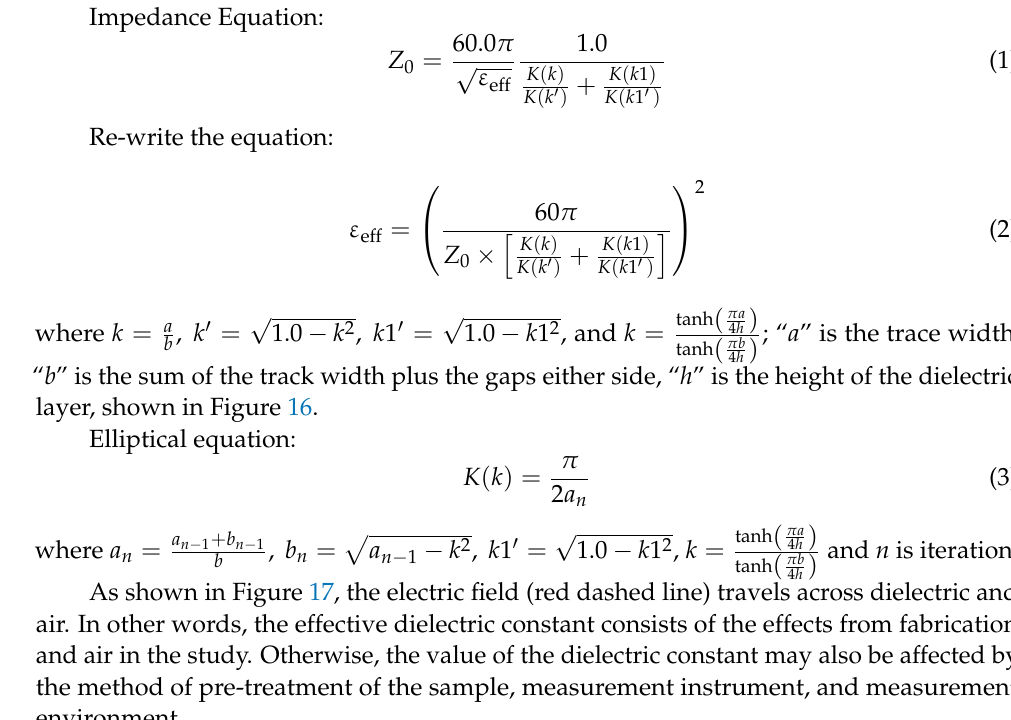
Figure 19. The VNA measurement results of test vehicle (80 μm pad) and correlation with ANSYS results.